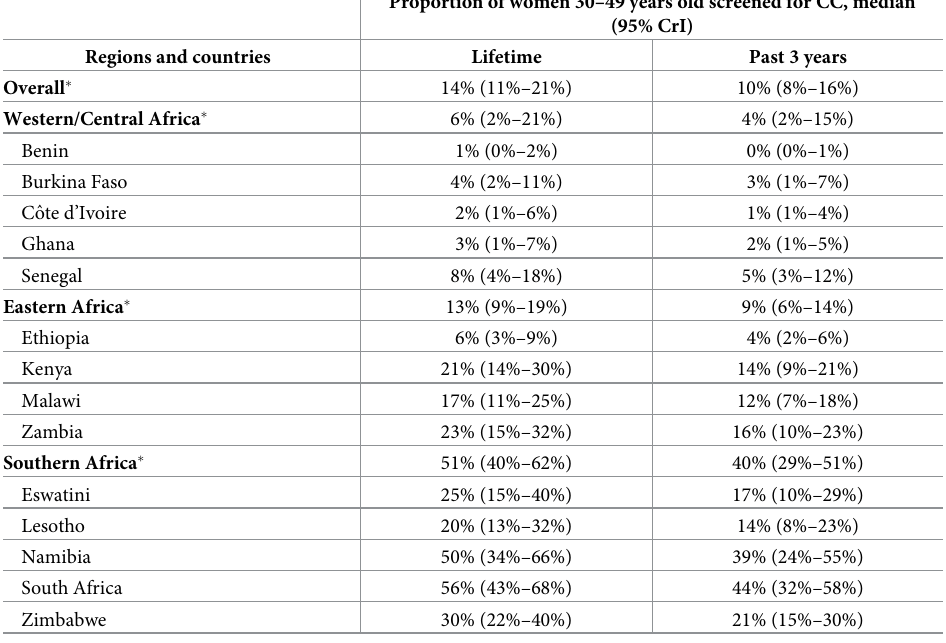
� The overall and region-specific estimates consider the uncertainty and the population sizes of countries without